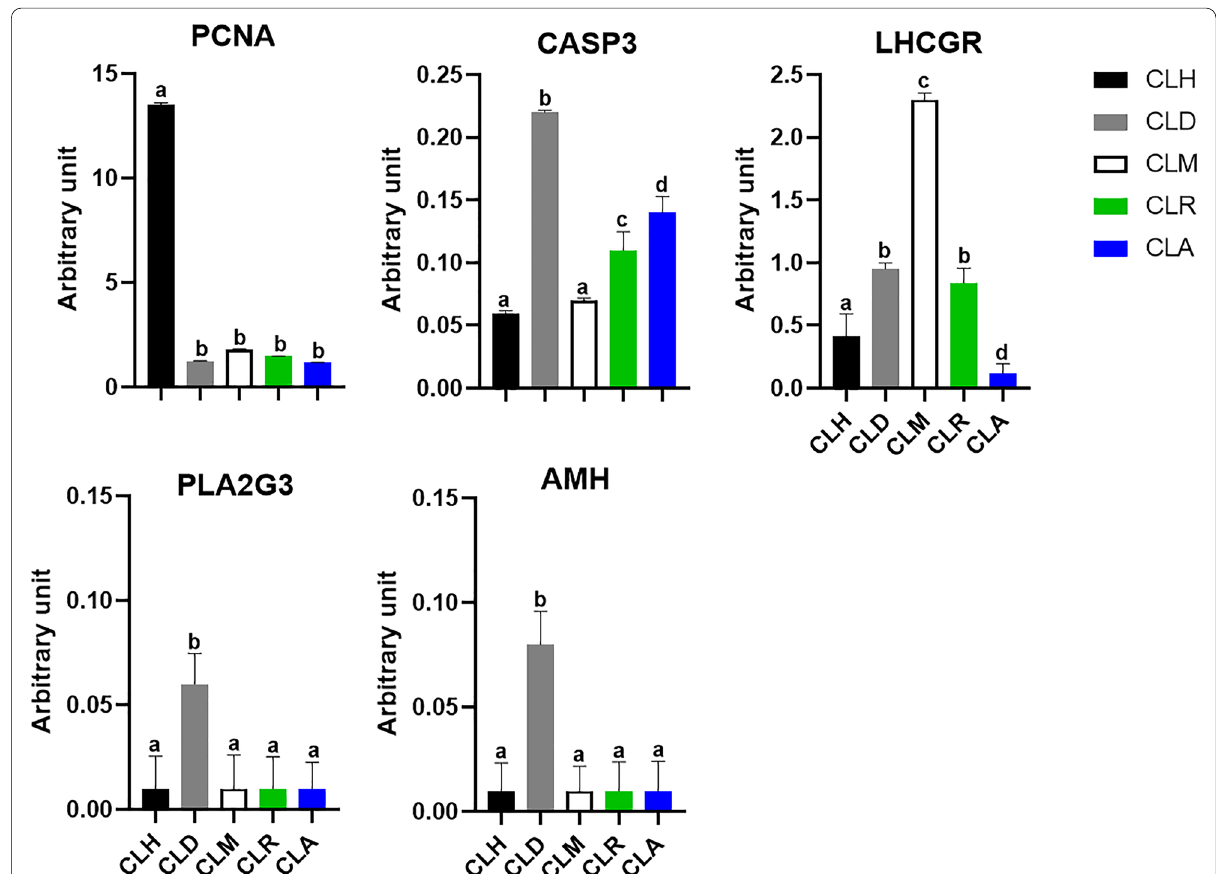
Fig. 1 Expression profile of PCNA, CASP3, LHCGR, PLA2G3, and AMH transcripts at different stages of corpus luteum in Egyptian buffaloes. Bars are presented as mean SEM. a,b,c,d Statistical differences between different stages of CL: hemorrhagic (CLH), developing (CLD), mature (CLM), regressed ± (CLR), and albicans